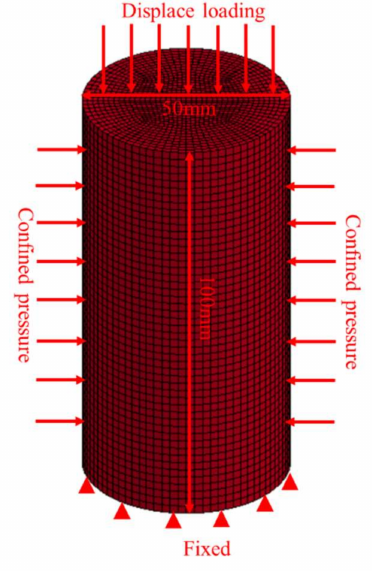
Figure 14. Relationship between h and γ p of deep-metamorphic limestone.